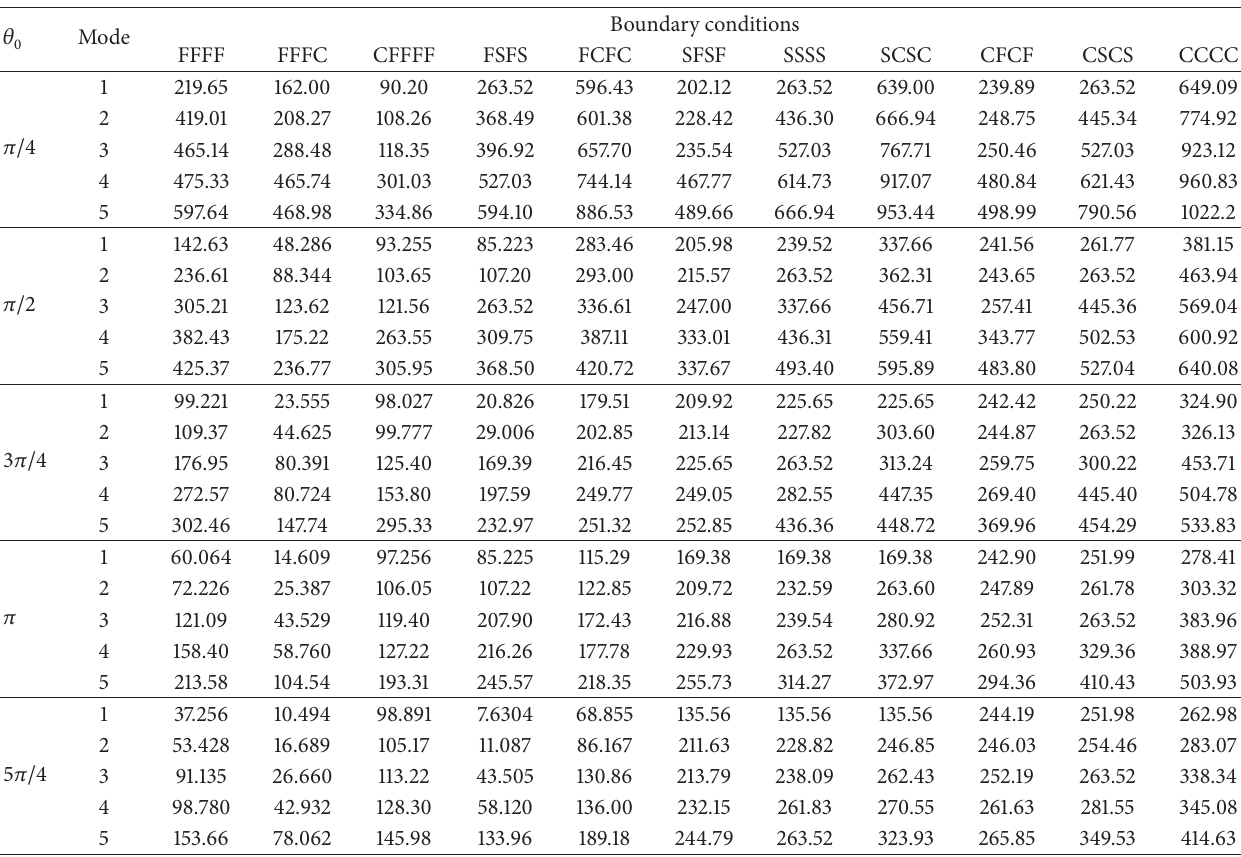
Table 10: The first five frequencies (Hz) of an open orthotropic cylindrical shell with various boundary conditions and circumferential dimensions ( 𝑅 = 1 m, 𝐿/𝑅 = 2 , and ℎ/𝑅 = 0.5 ).